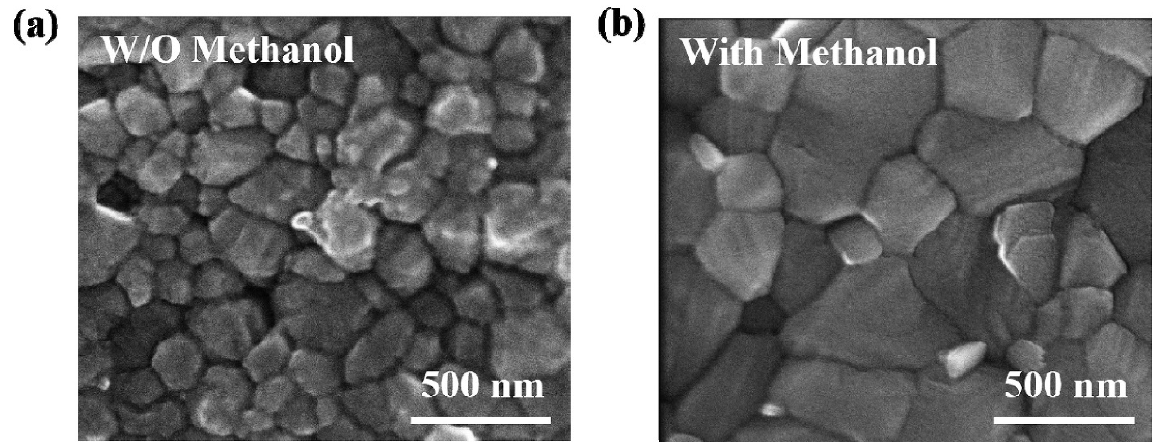
Figure 6. SEM images of the perovskite PV fabricated: ( a ) without and ( b ) with (5 vol%) methanol [125]. Reproduced with permission from Ref. [125]. Copyright 2019 Electrochimica